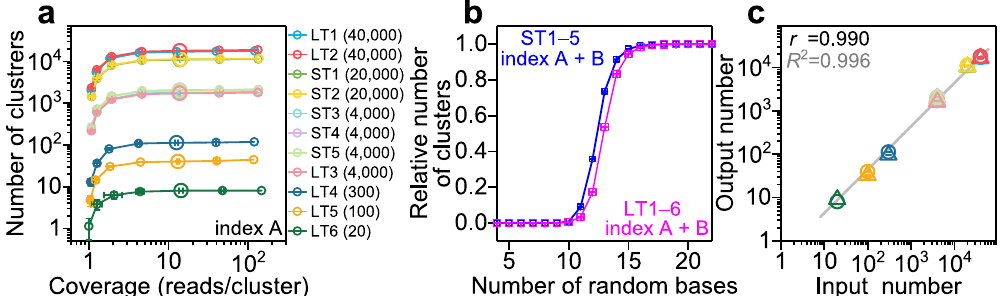
Figure 4. Absolute counting of each template. ( a ) Determined number of clusters as the function of coverage for index A. Distance = 2, Fixed base number = 4., Random base number = 20, and the effect of contaminated indices and misidentification were removed. Initial copy number of each template sequence in parentheses. ( b ) Dependency of the relative number of detected clusters on the number of random bases. Distance = 2, Fixed base number = 4, 10% of total reads sampled randomly (coverage is 13.4–20.3 for short templates, and 12.6–20.9 for long templates). ( c ) Correlation of input (x-axis), the number of molecules before PCR amplification, and output (y-axis), the result of digital counting. The output number was determined from Figs 4a and S5 at a coverage of 12.6–20.9 shown by the large symbols. Gray line indicates a fitting line with slope 1 (fixed) in log scale. Circles and triangles correspond to index A and index B, respectively. Pearson’s product-moment correlation coefficient r and coefficient of determination R 2 of the linear fitting are shown. Error bars represent standard deviation (n =